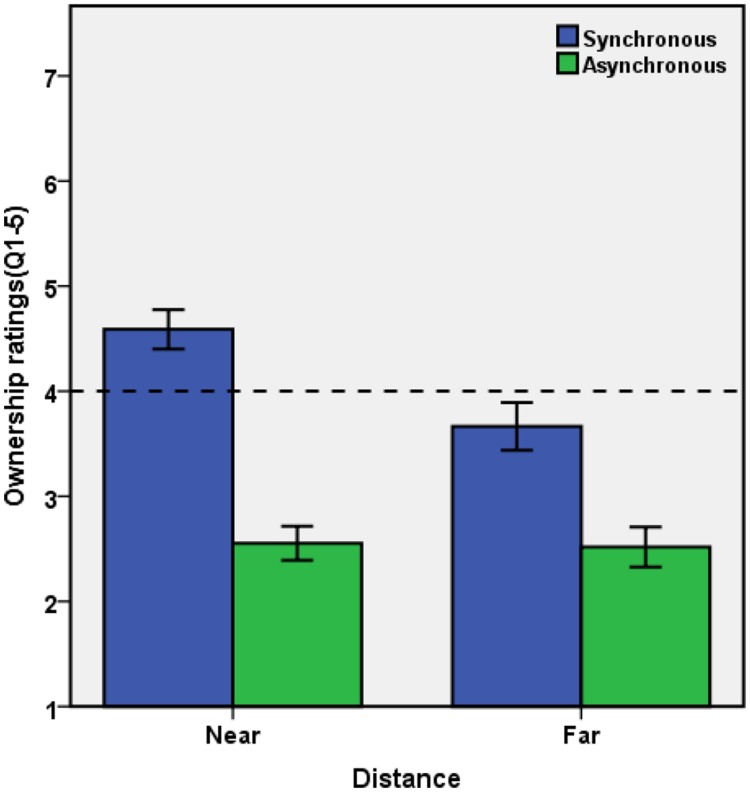
Mean Score of Ownership Questions (Q1–Q5) for priming condition. Error bars represent ±1 SE.